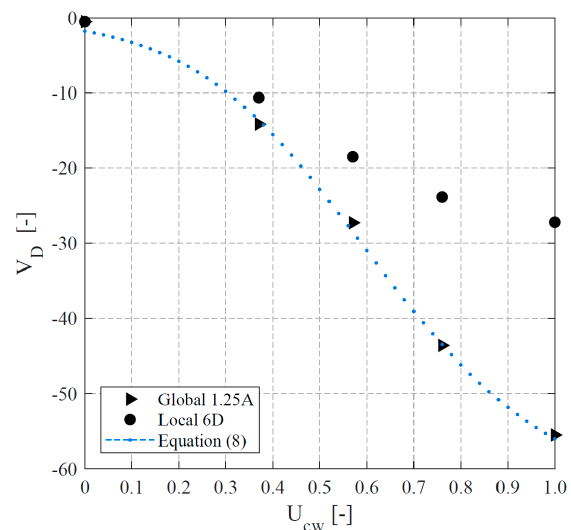
Figure 15. Comparison between non-dimensional local erosion volumes V D (see Equation (3)) of pile 1–4, depicted over the wave current velocity ratio U cw (see Equation (2)) for circular areas of 6 D and global erosion volumes for rectangular areas of 1.25 times the structure footprint length (1.25 A).